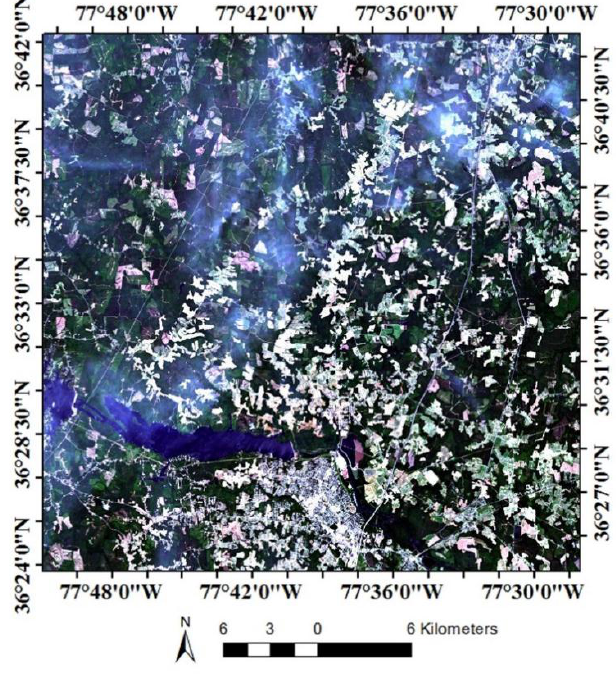
Figure 2. A sub-image of Landsat-8 acquired on 13 July 2014 is shown as a color composite (Band 4 as red, Band 3 as green, and Band 2 as blue). Clouds as bright features are noticeable. The image is 1000 rows (30 km) by 1000 columns (30 km). The area is around Roanoke Rapids,